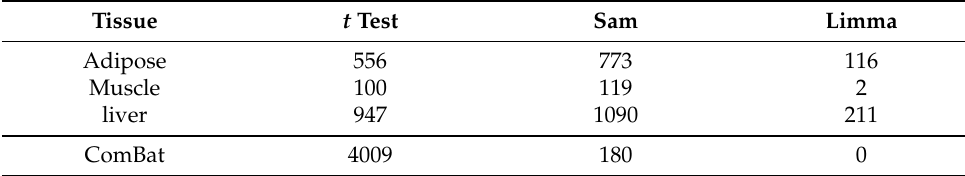
Table 4. Number of probes selected by other methods.